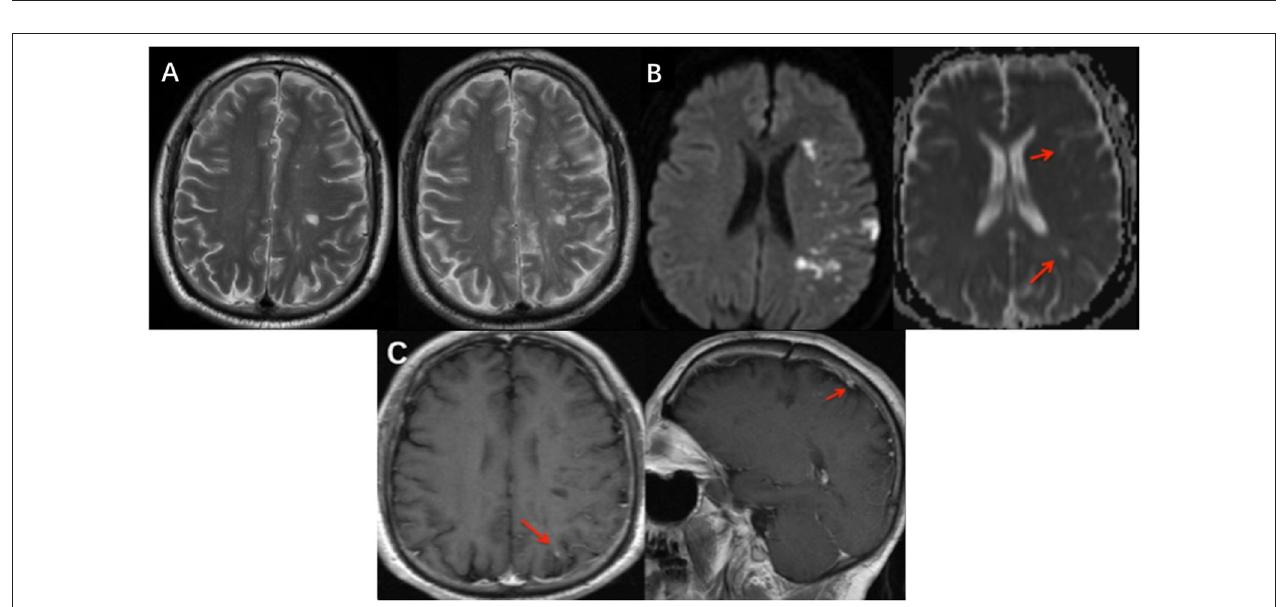
FIGURE 2 | Imaging features at different MRI scans. (A) New T2 lesions on EMRI (A-right) compared to the first MRI (A-left) which demonstrated DIT. (B) EMRI scan showed hyperintensity in the left frontal–parietal lobe and lateral ventricle nearby in DWI; however, these lesions were both hyperintensity and hypointensity signals in ADC. Red arrows showed hypointensity lesions. (C) Cranial EMRI scans revealed that lesion with an enhanced phase signal in the left frontal–parietal lobe (C-left), and also seed enhanced phase lesion in sagittal view (C-right). EMRI, emergency cranial MRI; DIT, dissemination of lesions in time; MRA, magnetic resonance angiography; ACA, anterior cerebral arteries; MCA, middle cerebral arteries; PCA, posterior cerebral artery.